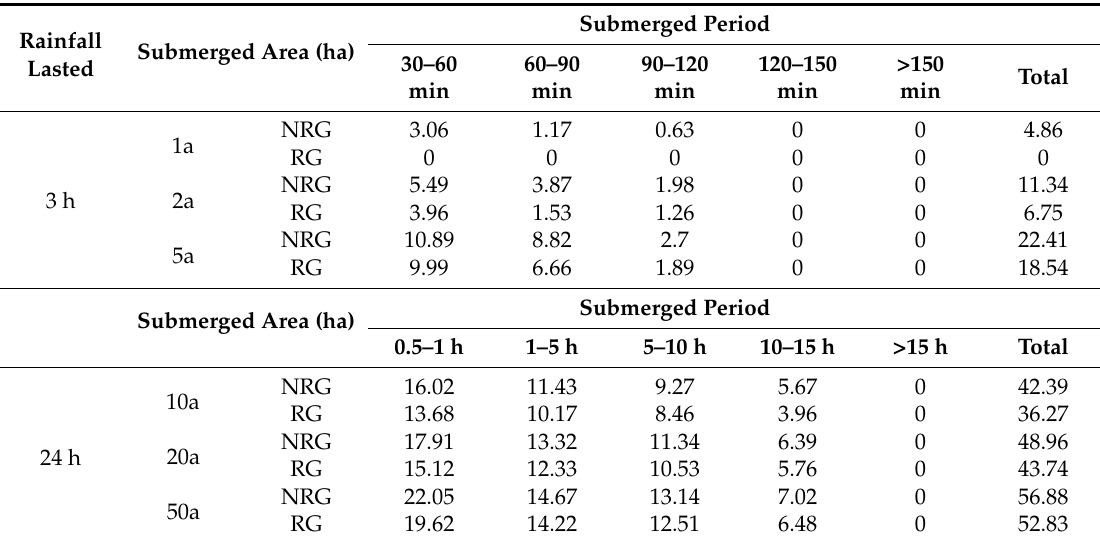
Table 6. Submerged range at different submerged